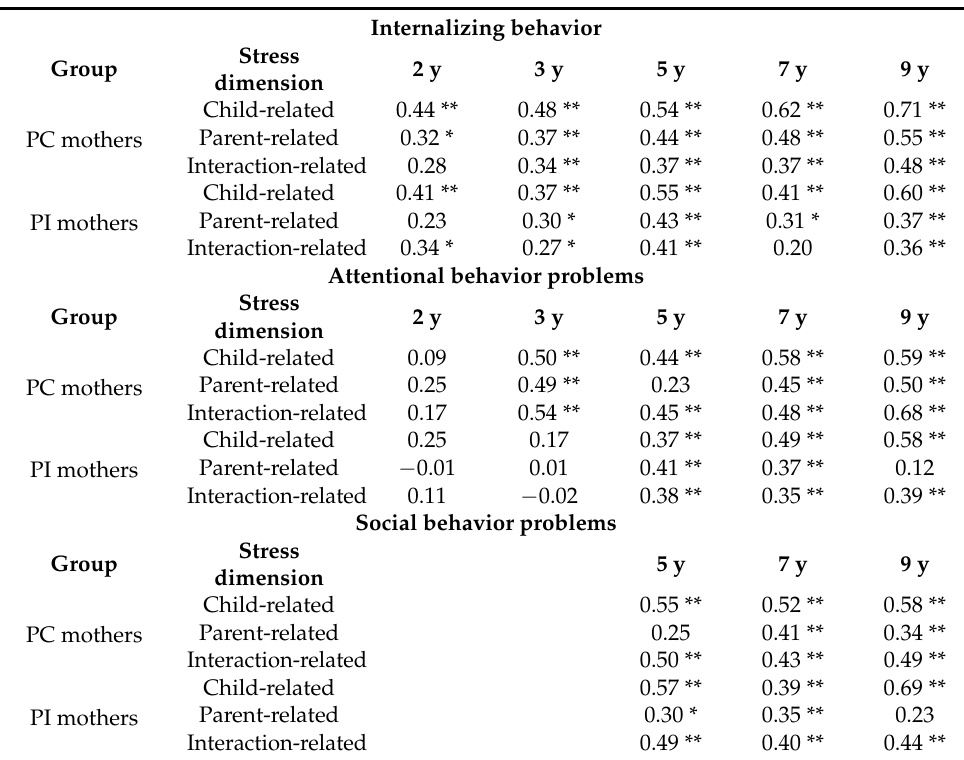
Table 2. Mean correlations between three aspects of child behavior and three dimensions of maternal stress reported by PI and PC mothers at 2, 3, 5, 7, and 9